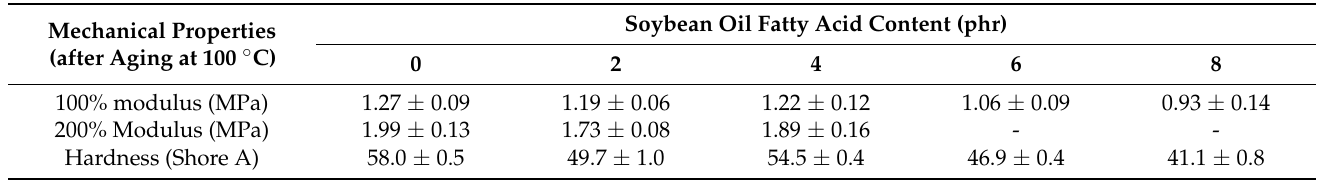
Data of tensile properties and hardness are shown as the mean ± 1SD, derived from five and three experiments, respectively. Table 9. Peak ratios of the ATR-FTIR spectra that represent the C=C, C–C bond, C=O, and COOH at (1660–1640),